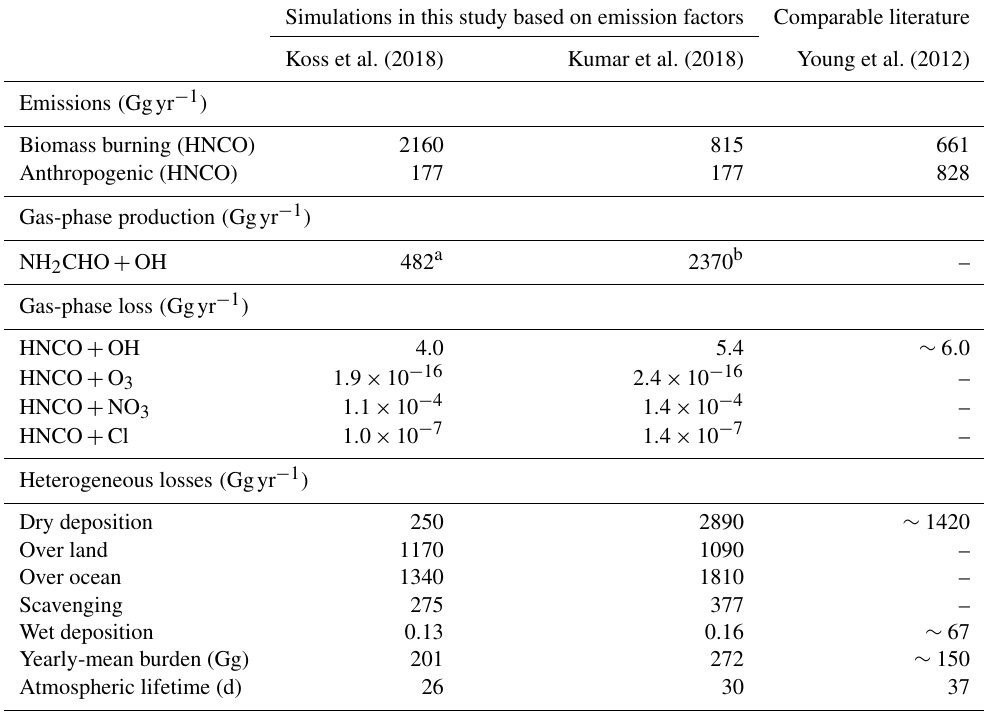
Table 1. Yearly global HNCO budget in 2011 for both biomass burning emission datasets by Kumar et al. (2018) and Koss et al. (2018). Additionally, the HNCO budget from Young et al. (2012) is given for comparison.